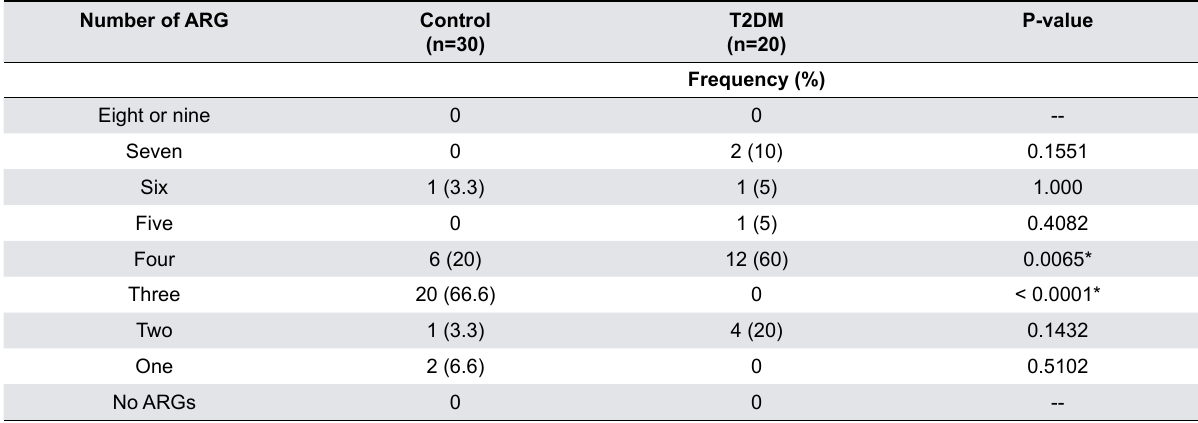
ARG: Antimicrobial resistance gene; T2DM: Type 2 diabetes mellitus; Fisher´s exact test; *Statistically significant Table 4- Frequency of positive samples to a different number of assessed Number of ARG